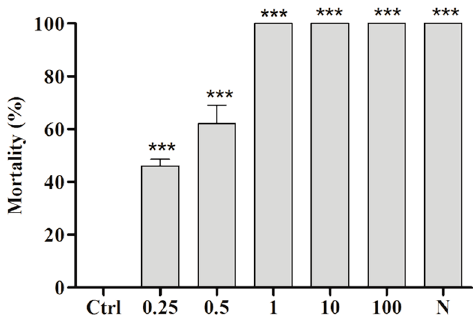
Figure 5. Cercaricidal activity of BAR against S. mansoni at the end of the 120-min exposure period. Ctrl (0.5% ethanol and filtered water); N (niclosamide at 1 µg/mL). The results were compared with the Ctrl; *** p < 0.001.